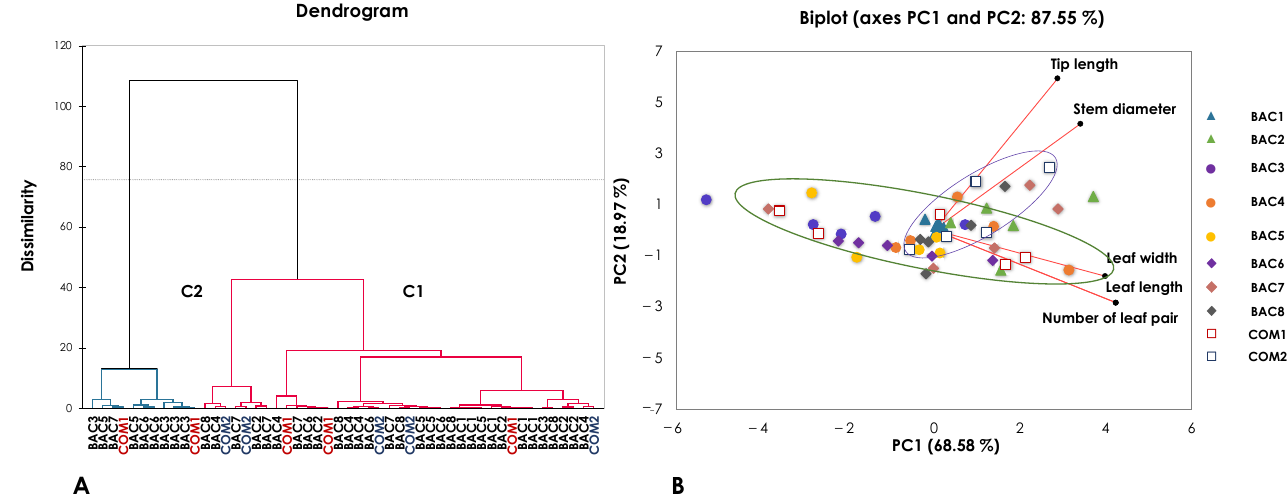
Figure 1. ( A ) The dendrogram of Gymnema inodorum samples generated from their physical char- acteristics. ( B ) The principal component (PC) analysis of the G. inodorum sample based on their phys- iological characteristics. C1–C2 represent di ff erent clusters displayed on the dendrogram, and the same clusters (color) are shown in the biplot.